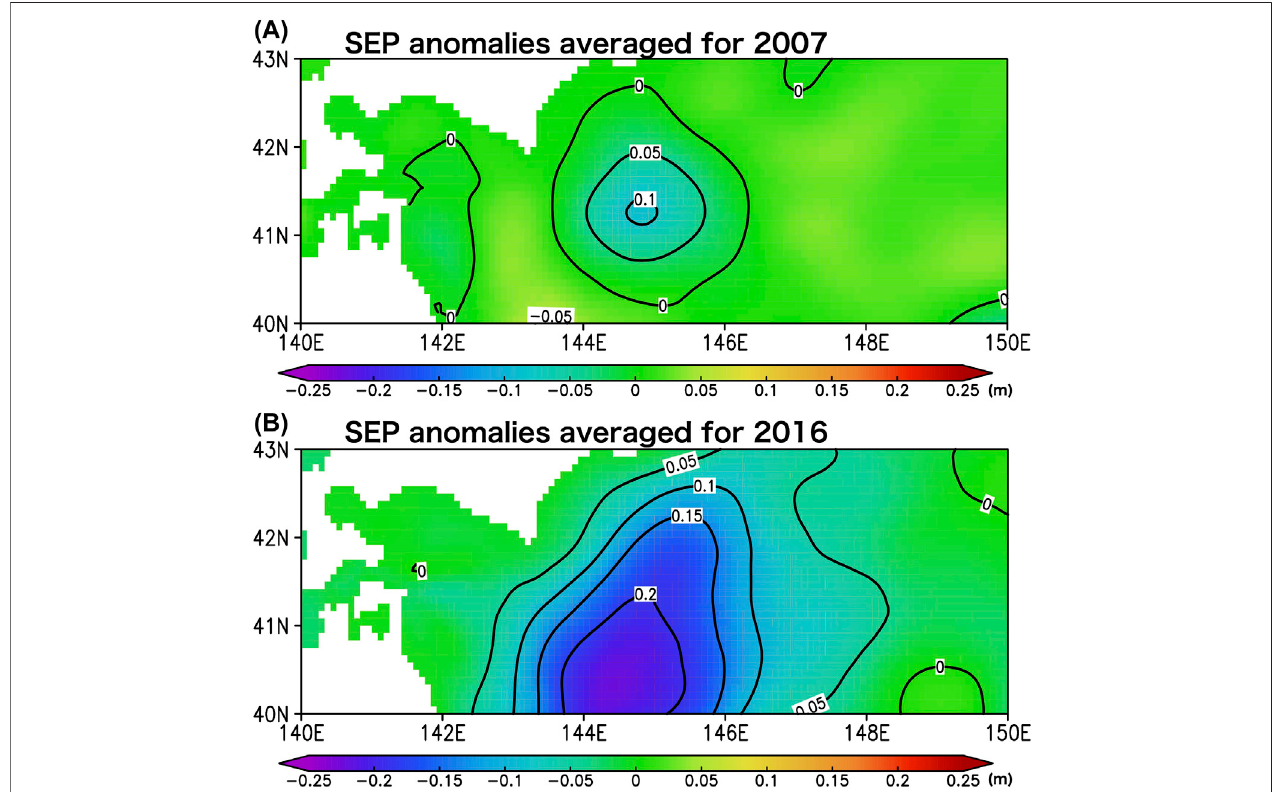
FIGURE 5| (A) Spatial distribution of the yearly averaged SEP anomaly for the year 2007 (color shades). The yearly averaged SSH anomalies for the year 2007 are shown by black contours. The unit is m. (B) Same as (A) but for the year 2016.